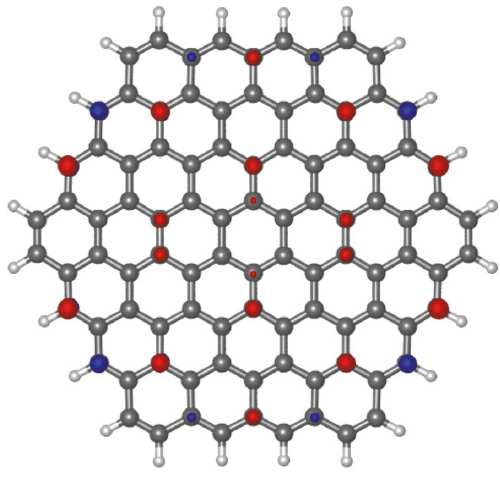
Figure 10: H 4 HOMO 2.